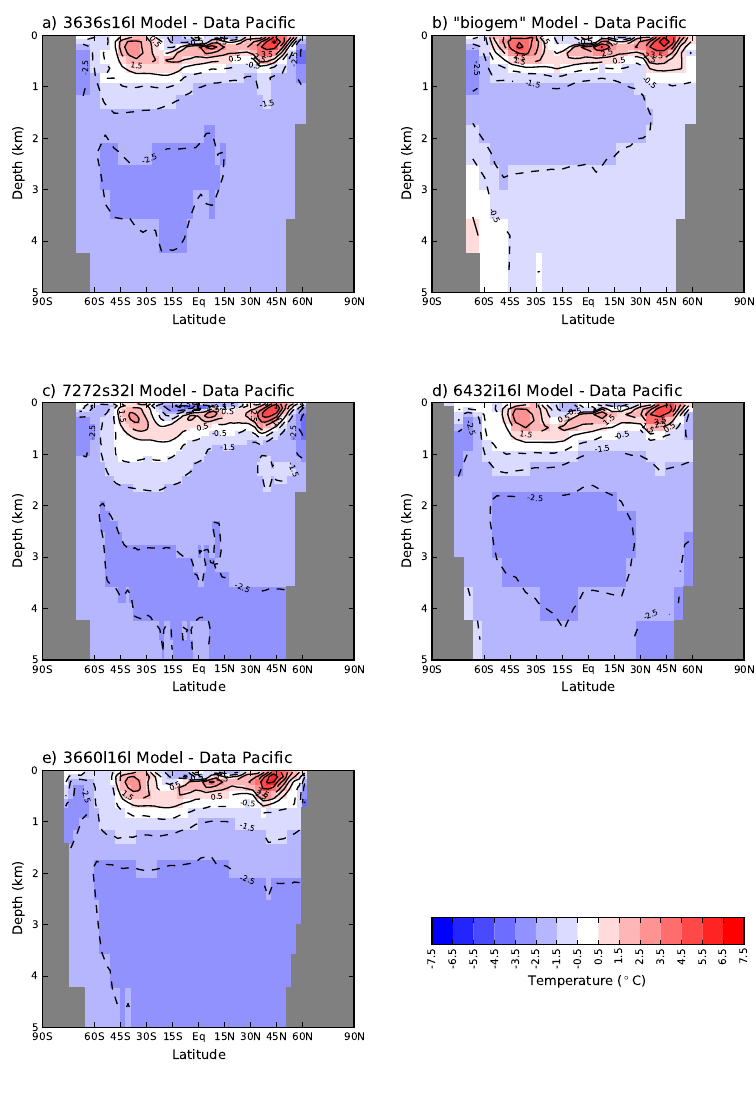
Fig. 14. Annual-mean “model minus observation” differences of zonally-averaged temperature in the Pacific, for the five experiments. Observations have been interpolated and extrapolated (see text) from the Locarnini et al. (2006)